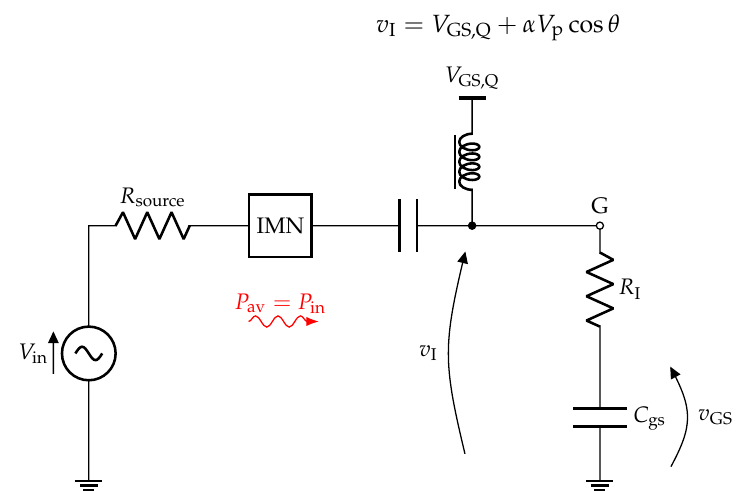
Figure 11. Input section of the TL PA adopting the quasi-static FET